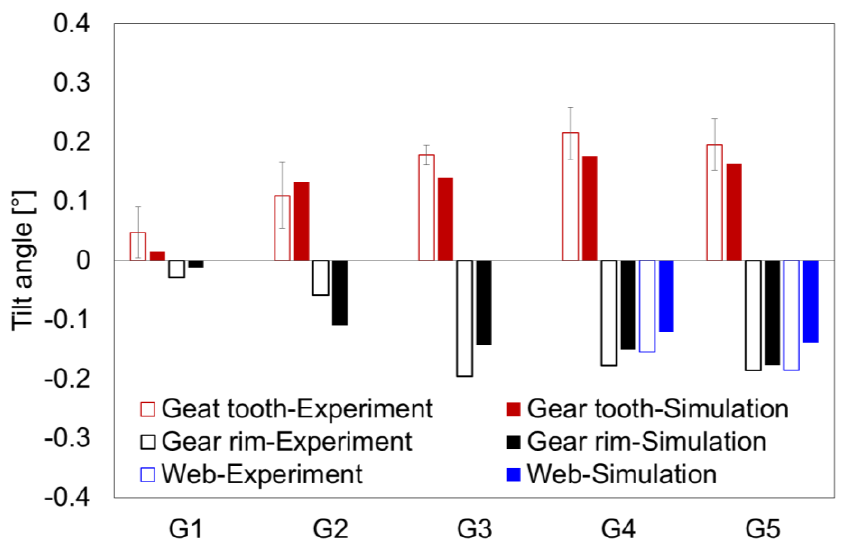
Figure 13. Comparison of the experimentally determined and calculated tilt angles of the gear tooth, gear rim, and web for geometry types G1 to